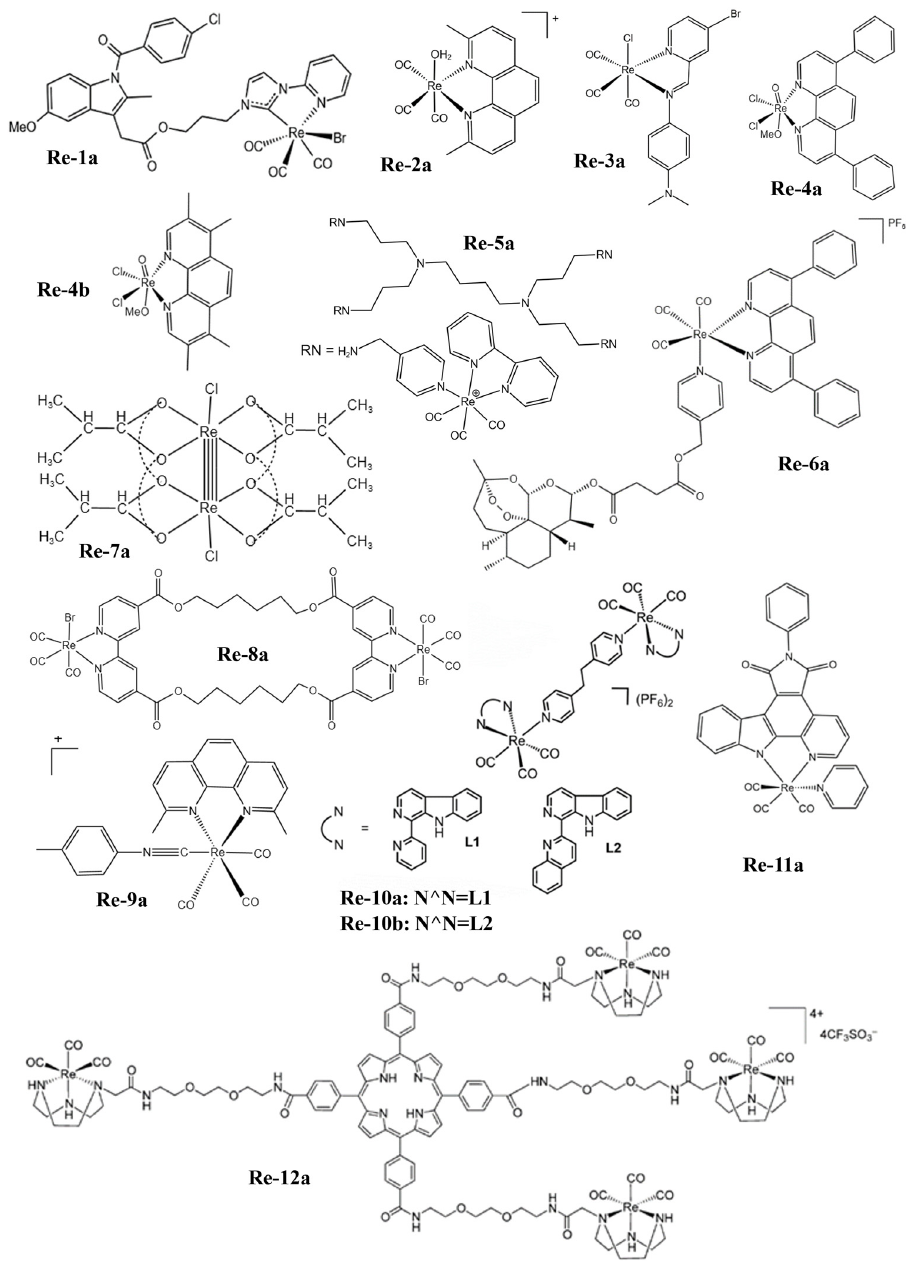
Figure 1. The structures of some Re complexes (Re-1a − Re-12a) involved in this review.